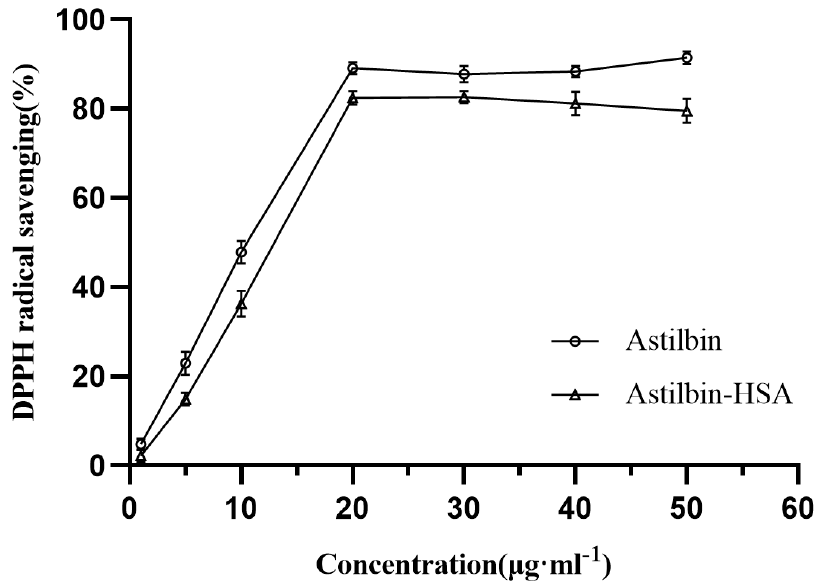
Figure 9. The antioxidant activity in the samples with different concentrations of astilbin (C Astil- bin :C HSA =